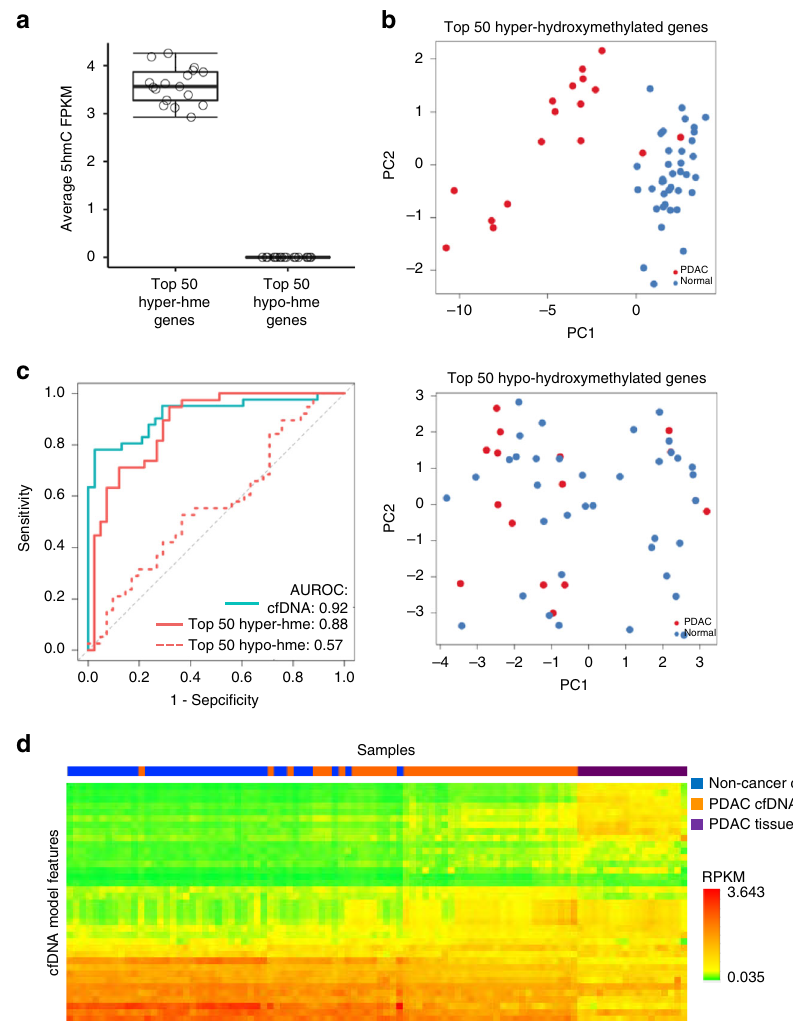
Fig. 5 Tissue-derived 5hmC features are able to classify PDAC cfDNA. a Average 5hmC FPKM values over top 50 hyper-hydroxymethylated (hyper- hme) genes with the highest 5hmC occupancy compared with the top 50 hypo-hydroxymethylated (hypo-hme) genes with the lowest 5hmC occupancy in PDAC tumor tissues ( n = 17). Boxplot center lines represent median, bounds of box represent 25th and 75th percentiles and whiskers are Tukey whiskers. Each dot represents an individual PDAC tumor tissue. b PCA plots showing non-cancer (blue) and PDAC (red) cfDNA cohorts using top 50 hyper- hydroxymethylated (upper panel) and top 50 hypo-hydroxymethylated (bottom panel) genes as features. c ROC curves for predictive model using features discovered in cfDNA (teal), top 50 genes with highest 5hmC representation in tissue (solid coral), or 50 genes with lowest 5hmC representation in tissue (dotted coral). d Heatmap showing FPKM values of all the gene features ( n = 37) used in cfDNA prediction model (represented in each row) in non-cancer cfDNA, PDAC cfDNA, and PDAC tissue 5hmC pro fi les (represented in each